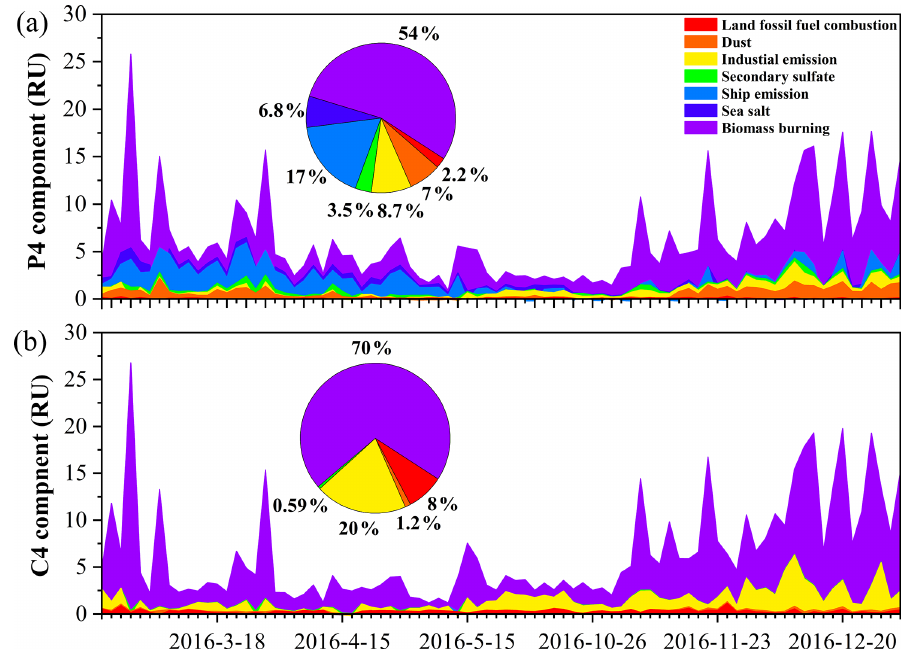
Figure 6. The time series of the P4 component of the WSOC (a) and C4 of the MSOC (b) in TSP samples over Bangkok in Thailand contributed by each factor resolved by positive matrix